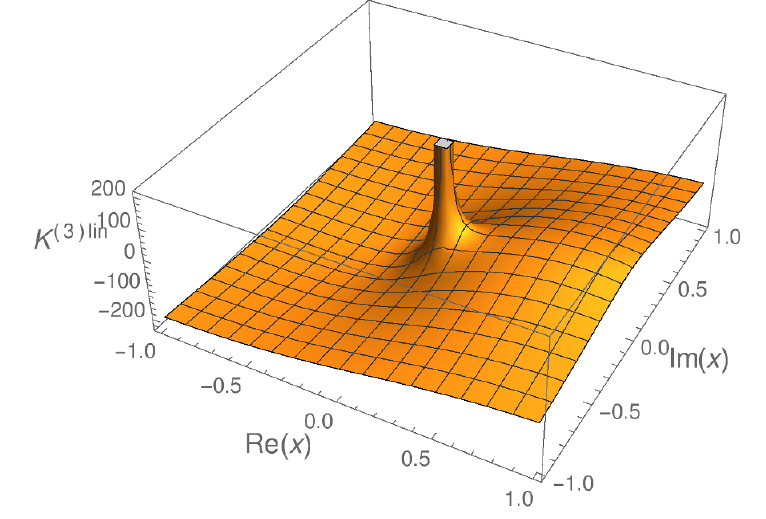
Figure 4 . The linear kernel K (3)lin in coordinate space in the physical region (cid:22) x = x (cid:3) . A special eigenfunction is U ( z